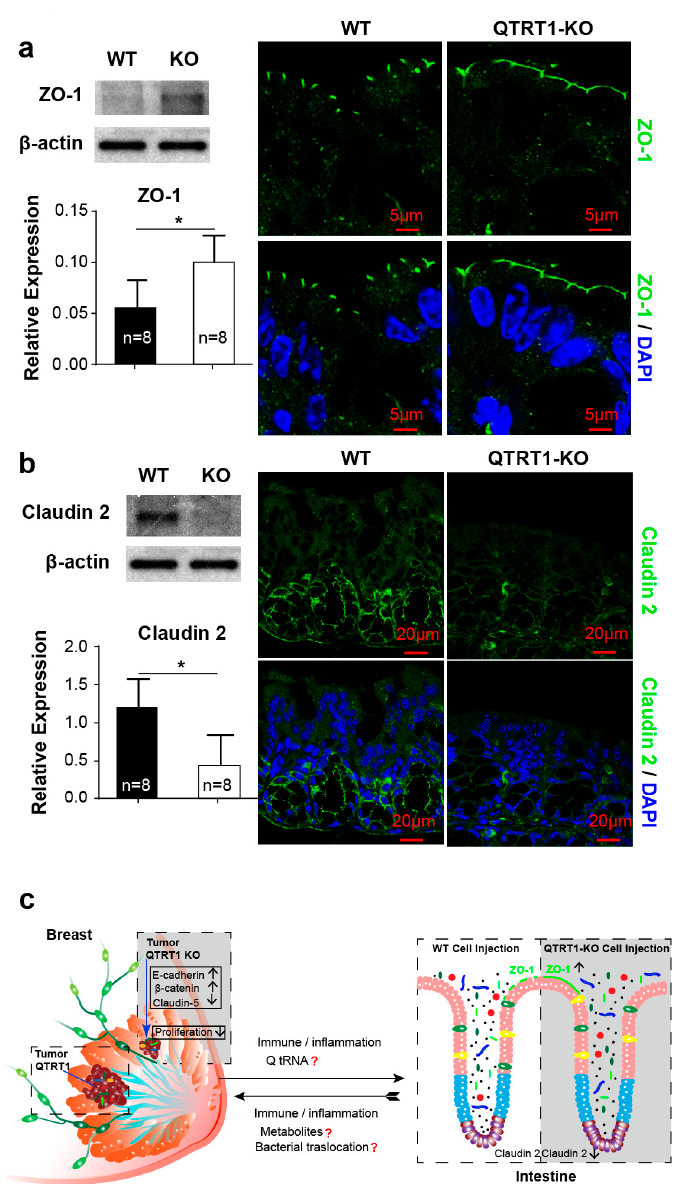
Figure 6. Altered tight junction proteins in the colon of a nude mouse model. Western blot analysis and immunofluorescence staining of ZO-1 ( a ) and claudin-2 ( b ) were performed on the colons of the nude mice injected with WT and QTRT1-KO MCF7 breast cancer cells. Proteins and DNA were stained with rabbit monoclonal anti-ZO-1/ mouse monoclonal anti-claudin-2 and anti-mouse Alexa Fluor 488 antibody, and DAPI, respectively. Scale bar is 5 µm in ( a ) and 20 µm in ( b ). The graphs show the relative expression of the target proteins detected by Western blot. Mean ± SD, n = 8; * p -value < 0.05, two-tailed Welch’s t -test. ( c ) The working model of QTRT1/Q - tRNA modification regulating gut-tumor-microbiome axis in breast cancer. Knockout of QTRT1 inhibited beast tumor proliferation and growth by altering the expressions of claudin-5, E-cadherin, and β -catenin in breast and changed the microenvironment of tumors. Meanwhile, the altered expression of intestinal junction proteins (claudin-2 and ZO-1) and altered bacterial community were found in the colon of mice with breast cancer cells. Microbiome-dependent tRNA Q-modifications regulate tumor growth and recruit microbiome to breast tumors. It is still unknown what the roles are of Q tRNA and metabolites in the process, and whether there is bacterial translocation from the intestine to the